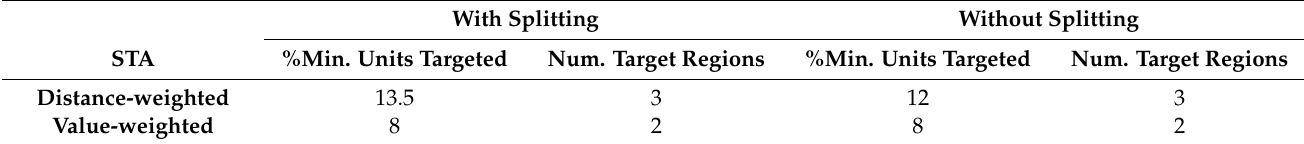
Table 2. Exact efficiency data for portfolios produced through applying the distance- and value- weighted STAs to a simulated dataset. Values shown correspond to a target case percentage of 50%. With Splitting Without Splitting STA %Min. Units Targeted Num. Target Regions %Min. Units Targeted Num. Target Regions Distance-weighted 13.5 3 12 3 Value-weighted 8 2 8